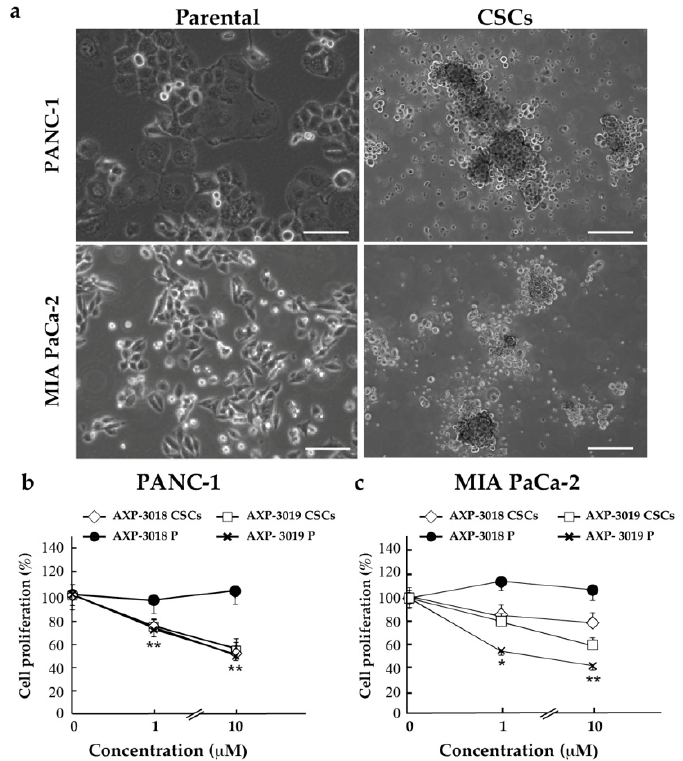
Figure 3. CSCs are sensitive to GAPDH inhibitors. PDAC parental (P) cells and cancer stem cells (CSCs) were treated with the h GAPDH inhibitors AXP-3018 or AXP-3019 at 1 μ M or 10 μ M. ( a ) Representative images of parental and CSCs after stemness induction. ( b , c ) Percentage of cell proliferation of parental (P) and CSCs after AXP-3018 or AXP-3019 treatment at the indicated conditions. The percentage of viable cells was calculated using Resazurin assay. Statistical analysis of treated vs untreated cells, * p < 0.05 and ** p < 0.001. Scale bar, 50 μ M.